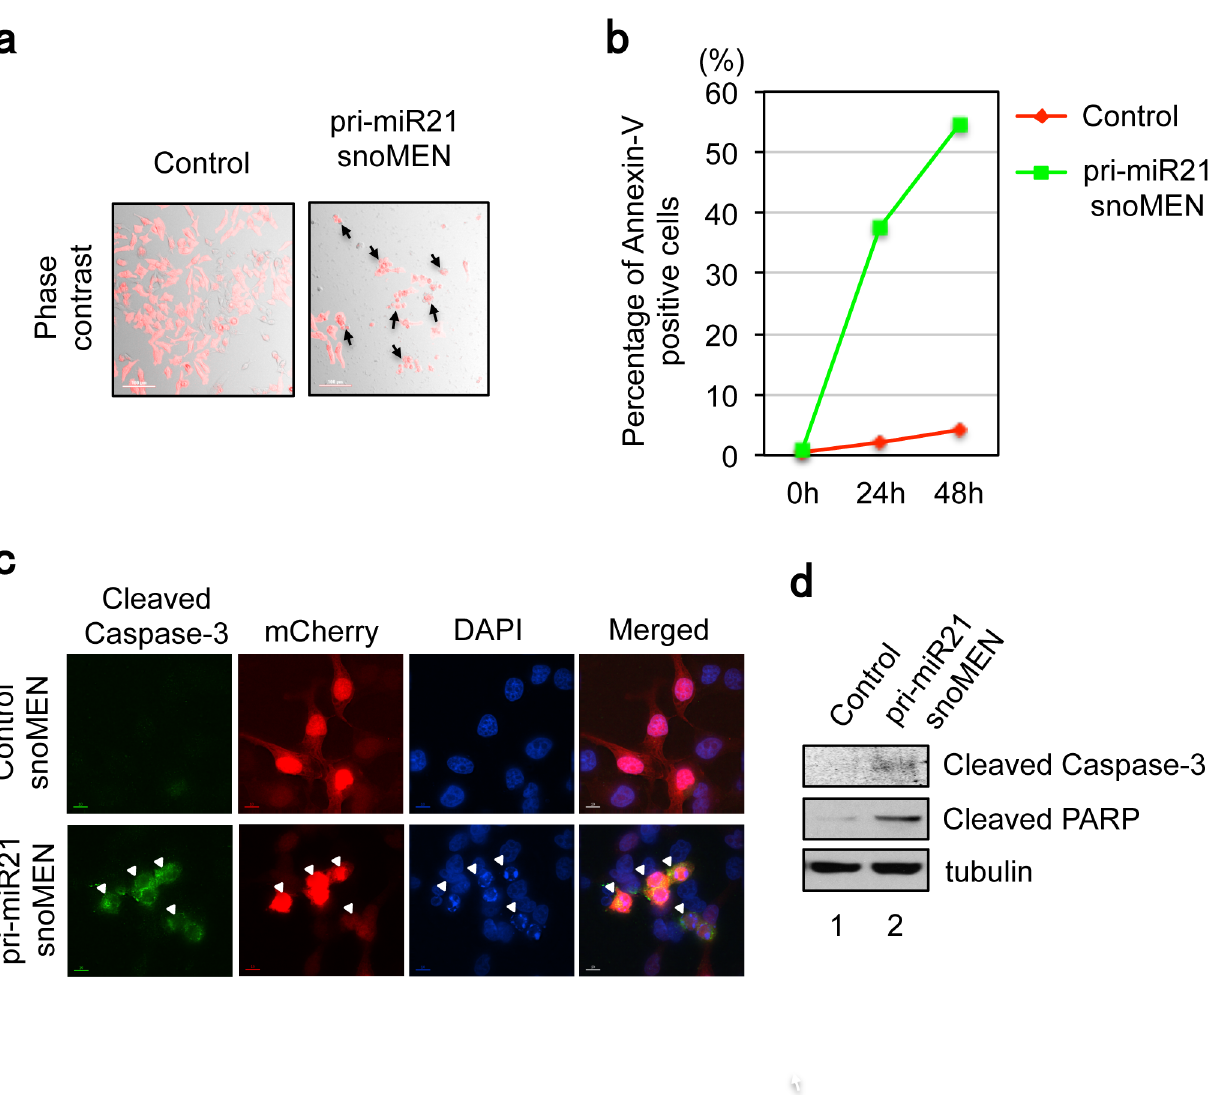
Fig 2. miR21 knock-down by snoMEN vector resulted in apoptosis phenotype. ( a ) Micrographs showing examples of apoptosis induction in HeLa cells transfected with pri-miR21-snoMEN. Images were taken 72 hours after transfection. Arrows indicate the cells showing an apoptosis phenotype. Scale bar is 10 μ m. ( b ) Graph shows a time course of changes in the population of Annexin-V (apoptosis marker) positive cells after transfection with either pri- miR21-snoMEN (Green), or Control (Red). The cell number was counted using FACS. Annexin-V signal was detected using Guava Nexin Reagent (Guava technologies). ( c ) Images show localisation pattern of DNA (DAPI, Blue), a transfection FP-marker of either pri-miR21-snoMEN/Control (mCherry, Red) and an Apoptosis marker (Cleaved Caspase-3, Green). Arrowheads show Apoptosis marker positive cells. Scale bar is 10 μ m. ( d ) Western blot showing maker proteins in HeLa cells transfected with pri-miR21-snoMEN/Control for 24 hours prior to protein extraction. Whole cell lysates were analysed using the indicated antibodies.